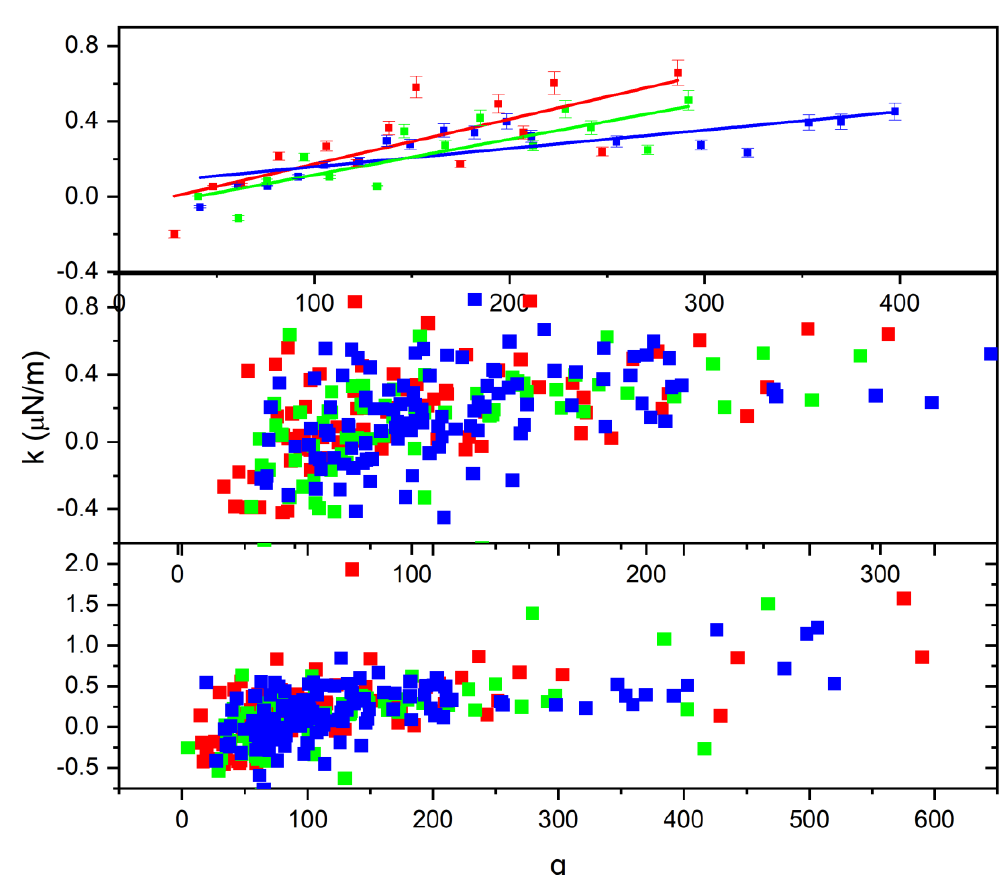
Figure 11. The relationship between the spring constant and the charge developed on the cell. The radiation incident on the cancer cells delivers the right amount of ionization en- ergy to result in dielectric breakdown. When the breakdown of the cell membrane in- creases, the conductivity and charge density increase. Thus, a material’s conductivity is closely related to the ability of its charge to be transported through its volume by an ap- plied electric field. The permittivity describes the material dipoles’ ability to rotate or for its charges to be stored in response to an external field [34]. An external field causes ex- treme polarization, leading to torque due to the misalignment of induced dipoles. The membrane structure is rearranged to form aqueous pores that increase the membrane’s